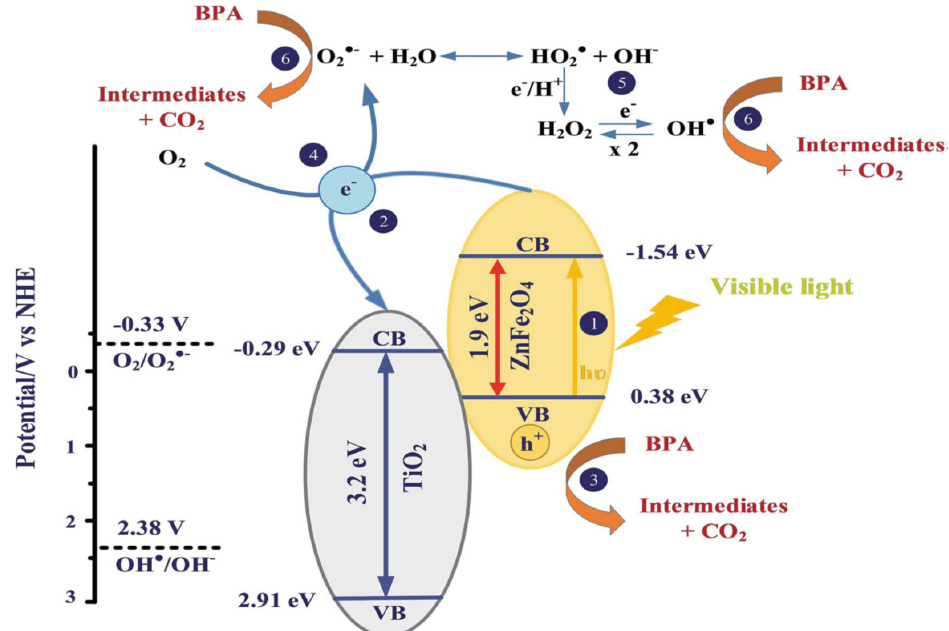
Figure 13. Schematic illustrating the visible light-driven photodegradation of BPA by a ZnFe 2 O 4 –TiO 2 photocatalyst under visible light